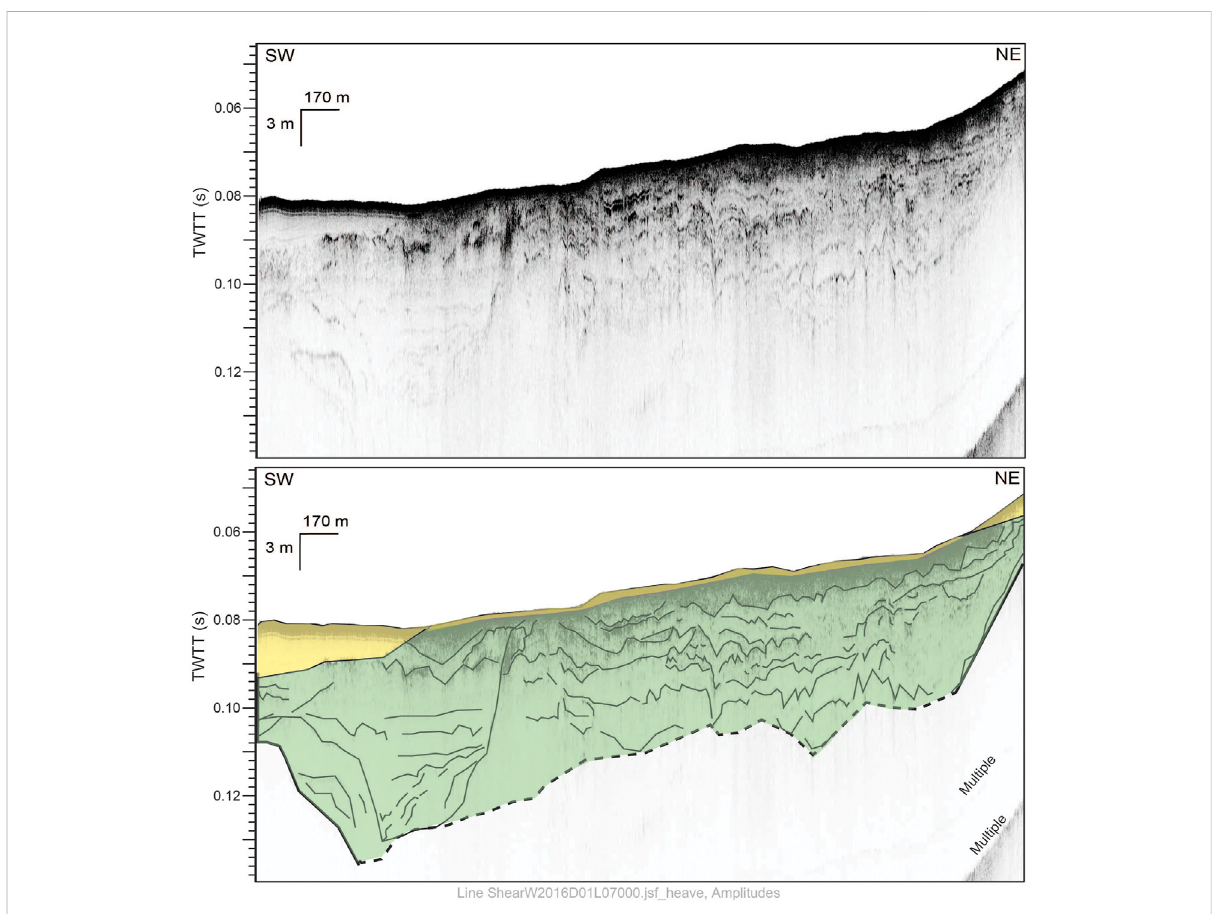
FIGURE 2 Uninterpreted (top) and interpreted (bottom) seismic line from area off Santa Cruz Island where Box 6 is located. Transparent yellow unit is interpreted as marine. Green unit with wavy re fl ectors is interpreted as terrestrial. High amplitude re fl ectors are traced in interpretation to show sedimentary structure. See Figure 3 for location (adapted from Johnson